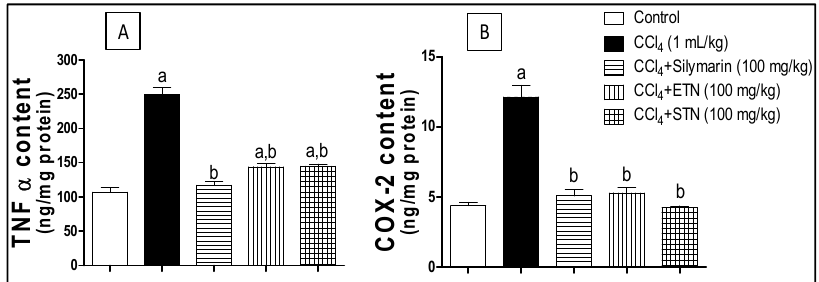
Figure 7. Effect of ETN and STN aqueous alcohol extracts on hepatic TNF- α (Panel A ) and COX-2 content (Panel B ) in rats subjected to chronic CCl 4 intoxication. * Data are the mean ± SD ( n = 6). a or b: Significantly different from control or CCl 4 group respectively at p < 0.05 using ANOVA followed by Tukey-Kramer as a post-hoc